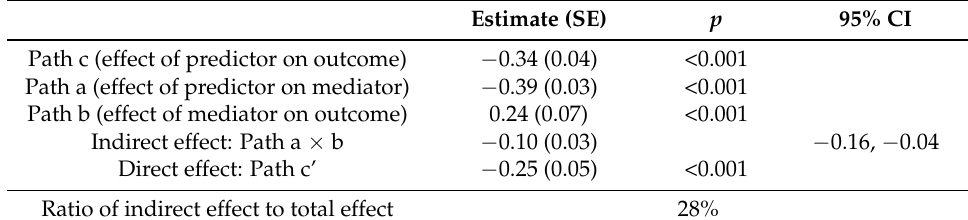
Table 3. Results of mediation analysis for Model 2 (parent-reported child disability). Estimate (SE) p 95%